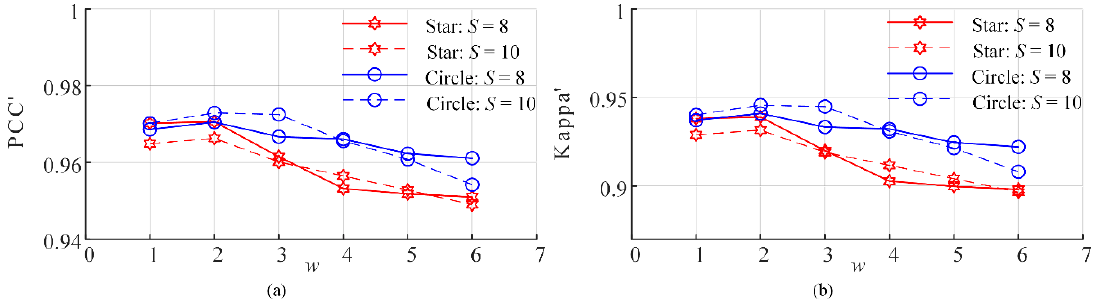
Figure 17. Accuracy of the PSA_MSA2 algorithm under different ranges of low attractiveness. ( a ) PCC’ and ( b ) Kappa’.